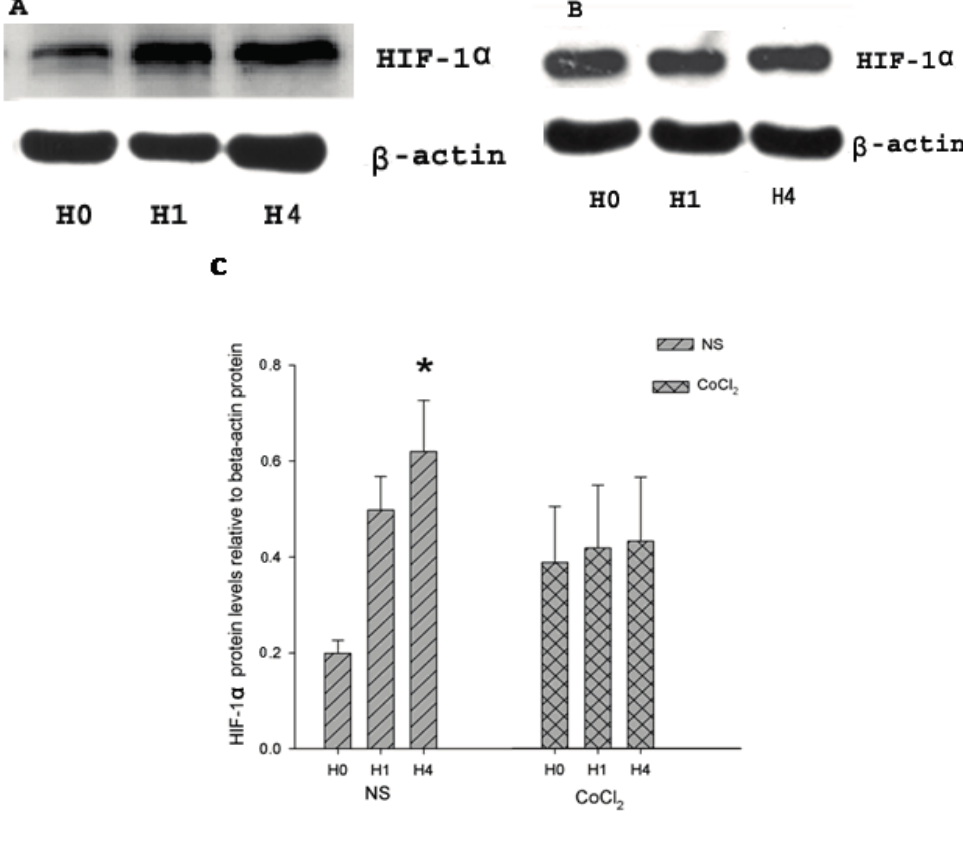
( A ) Western blot analysis of HIF-1 α and β -actin content in the hippocampus of hypoxic preconditioned mice pretreated with NS; ( B ) Western blot analysis of HIF-1 α and β -actin content in the hippocampus of hypoxic preconditioned mice pretreated with CoCl ( C ) Relative abundance of HIF-1á protein in hippocampus of hypoxia-preconditioned